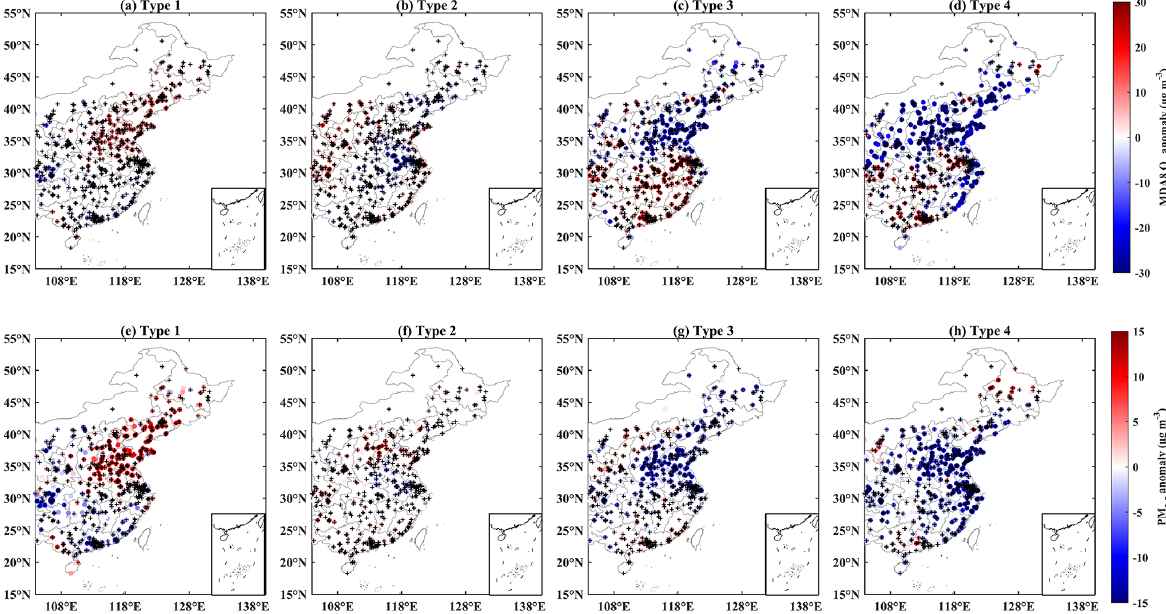
Figure 6. The MDA8 O 3 (a–d) and PM 2 . 5 (e–h) anomaly under the four SWPs, where the sites marked with a “ + ” indicate that the analysis of variance passed the significance level of 0.05.